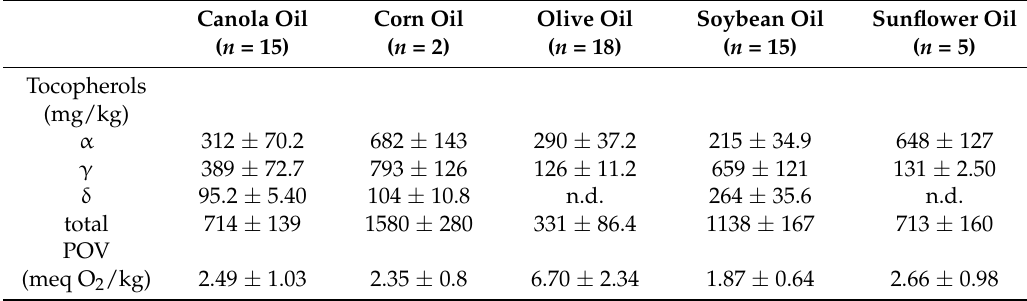
Table 1. Quantitation of tocopherols and POV of five commercial oil types obtained local markets in Bangladesh, Brazil, Austria and the USA a